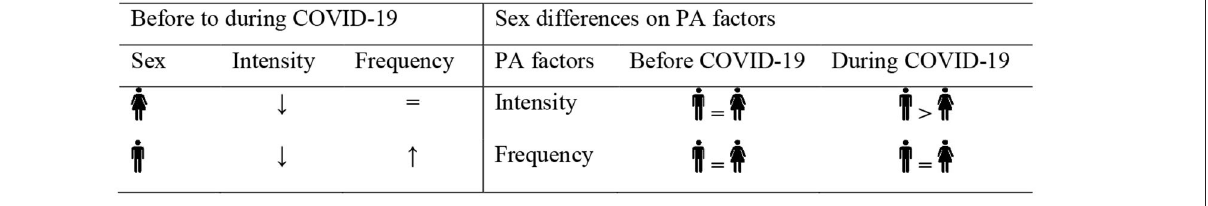
FIGURE 1 | Illustration of physical activity (PA) factors and sexes interaction before and during the coronavirus disease 2019